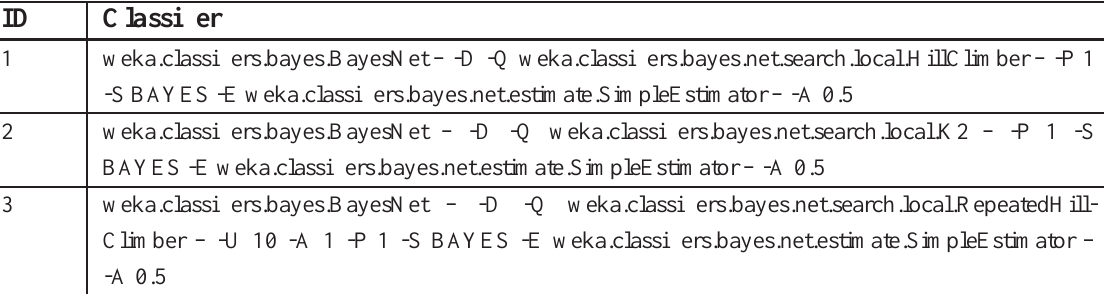
Table 1: The lineup of classifiers and configurations chosen to run as a batch job on the clustered implementation of Weka. This lineup was used to identify the best classifier configuration for predicting SCOP